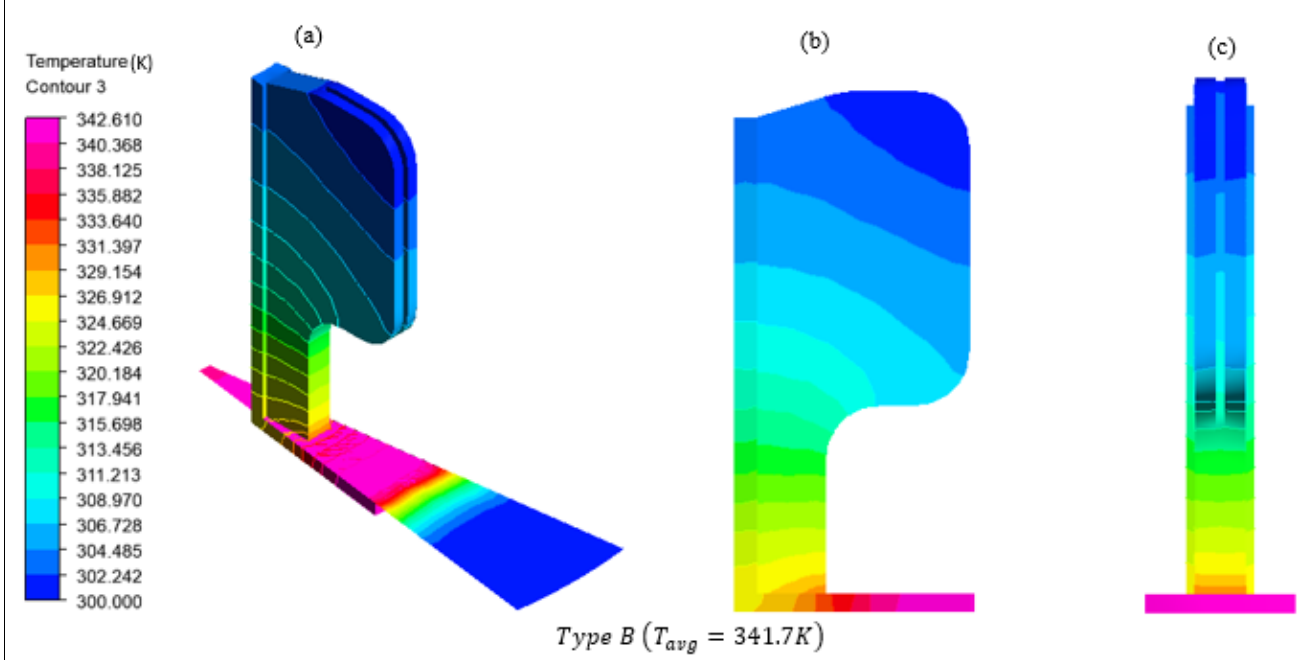
Figure 10: Temperature contour plot of the Type B radial HS at 𝑞̇ = 190 0 𝑊/𝑚 2 for (a) 3D view of Type B (b) Side view of Type B (c) Frontal view of Type B. Source: Authors, (2022).